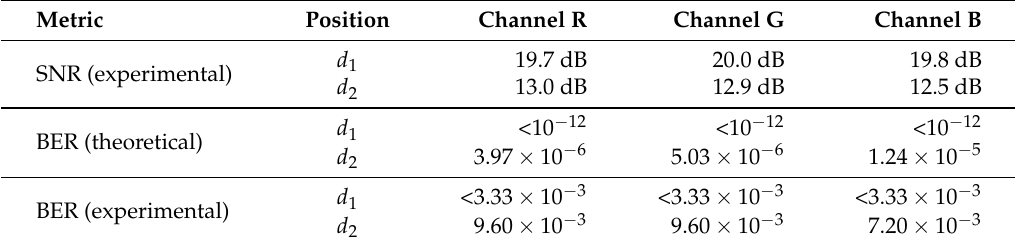
Figure 10. Image processing results from the experimentation using the sub-pixel setting. ( a ) Example of a frame obtained by the camera during experimentation, with insets of the regions of projection of each transmitter. ( b ) Estimated point spread function (PSF) for d 1 . ( c ) Estimated PSF for d 2 . Table 5. Signal-to-noise (SNR) ratio and bit error rate (BER) results by channel using point spread function weighted scheme in sub-pixel